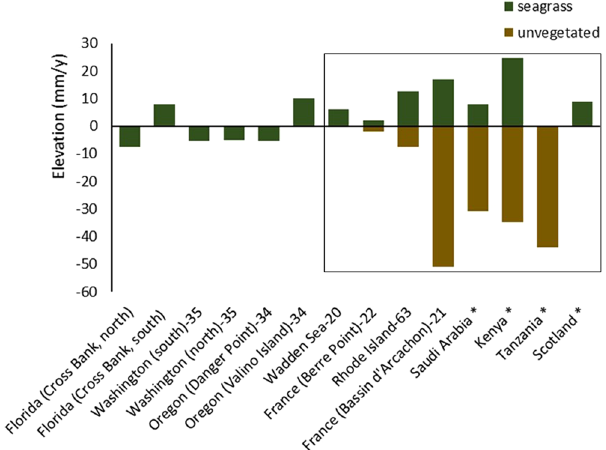
Figure 2. Sediment elevation rates (mm/y) in seagrass and unvegetated plots compiled from the literature (marked with the reference number) and this study (marked with an asterisk). The studies that reported sediment elevation rates for both seagrass and unvegetated plots are enclosed in the square. Note that the control plots in the Wadden Sea showed an erosion of < 0.5 mm/y, whereas in Tanzania and Scotland, there was no net annual sediment elevation change for seagrass and control plots